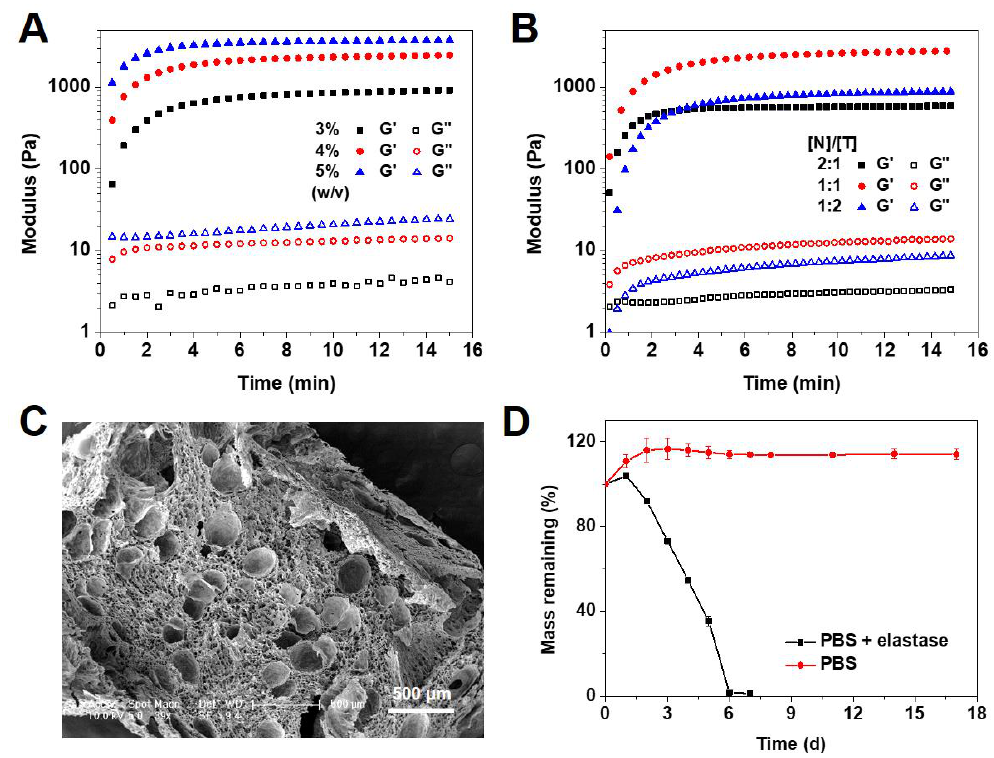
Figure 2. Storage modulus (G ′ ) and loss modulus (G ″ ) as a function of time for hydrogels ( A ) at polymer concentrations of 3%, 4%, and 5% (w/v) with [N]/[T] of 1:1 and ( B ) at a polymer concentration of 4% (w/v) with [N]/[T] of 2:1, 1:1, 1:2. ( C ) SEM images of the click polypeptide hydrogels. ( D ) In vitro degradation profiles of the hydrogels in PBS with or without 5 U/mL elastase.